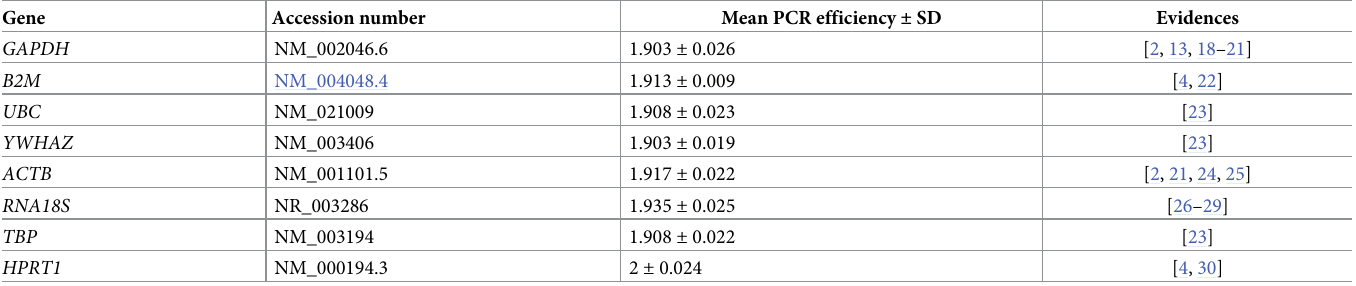
Table 1. Properties of the designed primers of the eight nominee reference